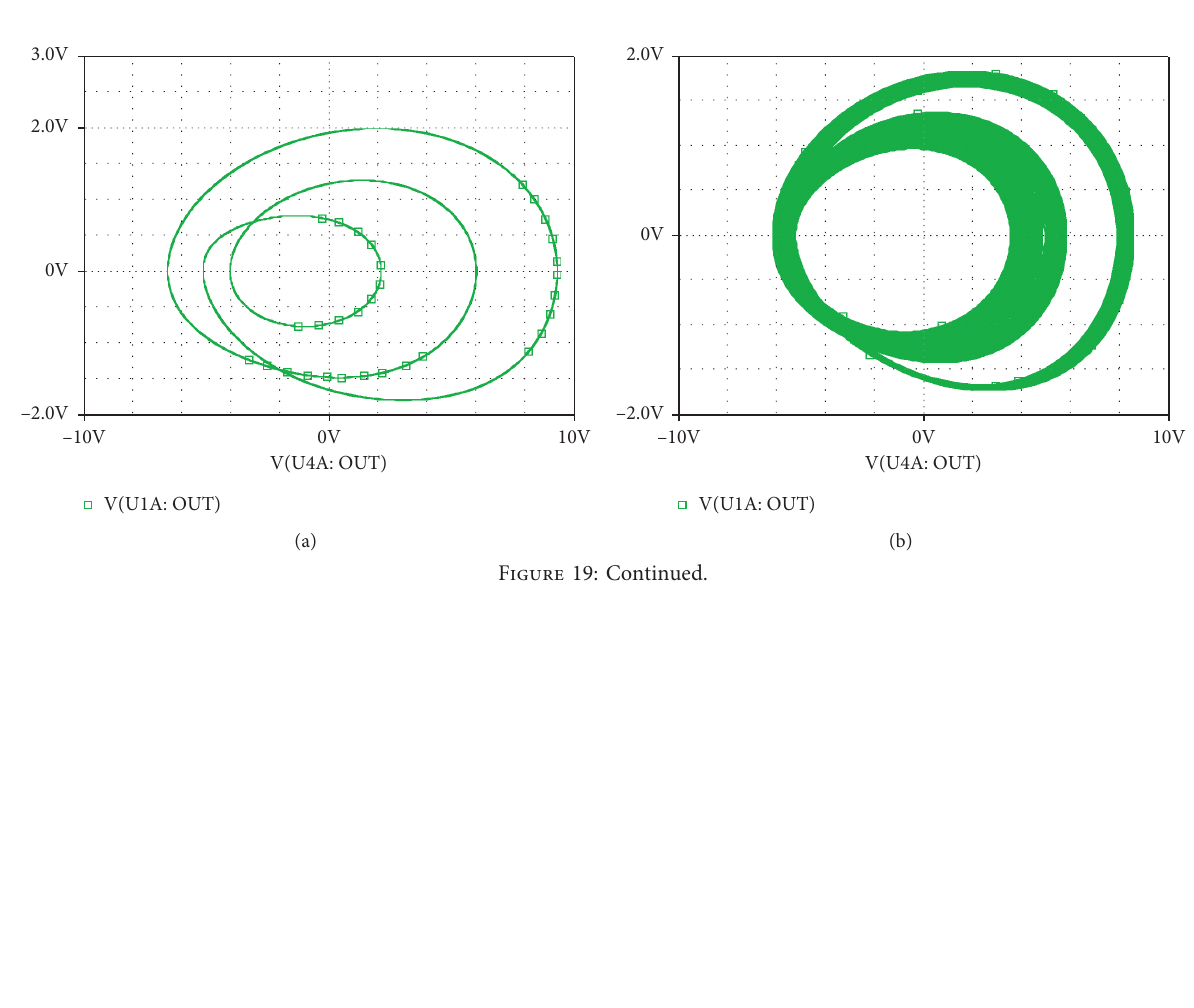
� 12 k Ω with the initial point ( 0 . 5 , 0 , 0 ) μ